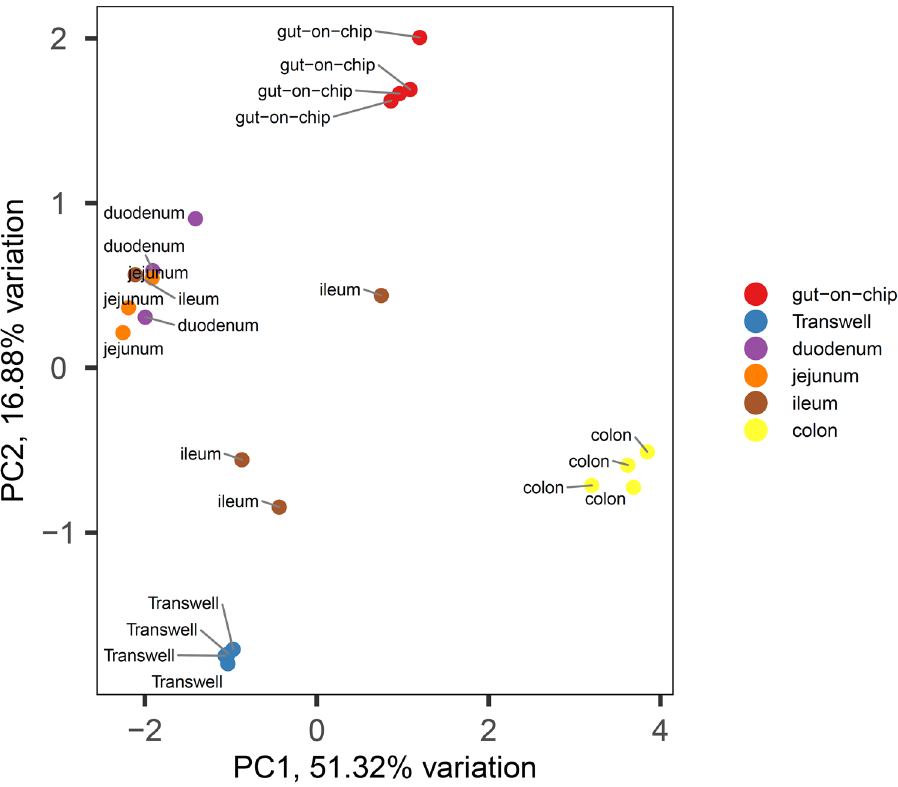
Figure 5. PCA plot of genomic expression data of 483 of human intestine-specific genes 24 from human duodenum, jejunum, ileum and colon tissues, and Caco-2 cells cultured in a gut-on-chip or Transwell system.